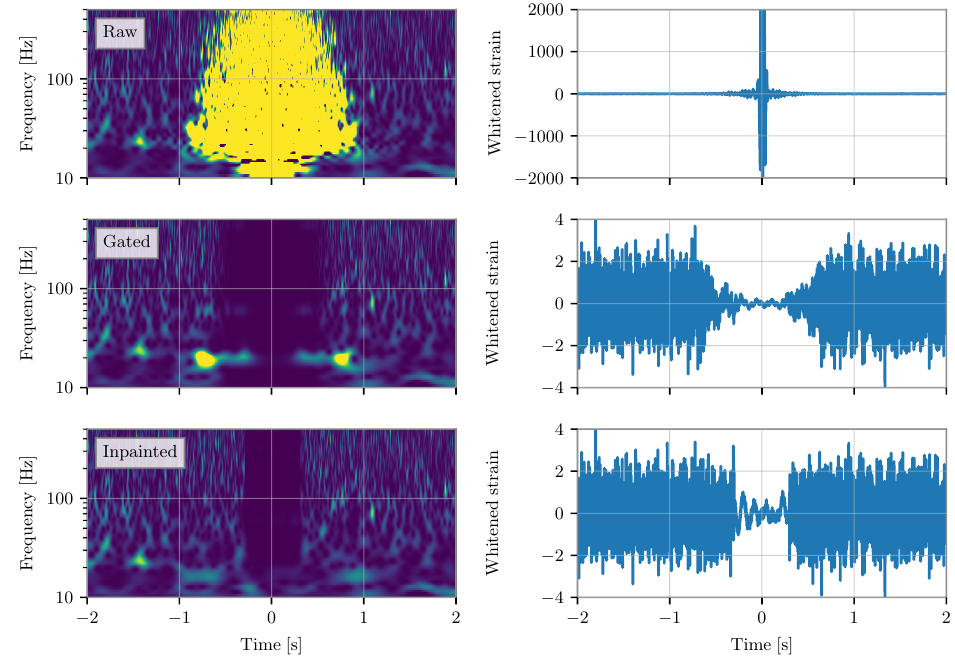
Figure 11. A comparison of the use of gating and inpainting to mitigate a loud noise artifact in the data. Left column: Spectrograms of whitened strain data from the LIGO Livingston detector before mitigation, after mitigation with pre-whitening gating, and after mitigation with inpainting. Right column: Whitened strain time series for the same three cases. Both gating and inpainting methods mitigate the excess power from the instrumental artifact but inpainting introduces fewer artifacts and disturbs less of the time series. This improved mitigation comes at the cost of additional complexity in the method and the requirement that a specific PSD is used to analyze the data after inpainting. Plotted data are accessed from GWOSC